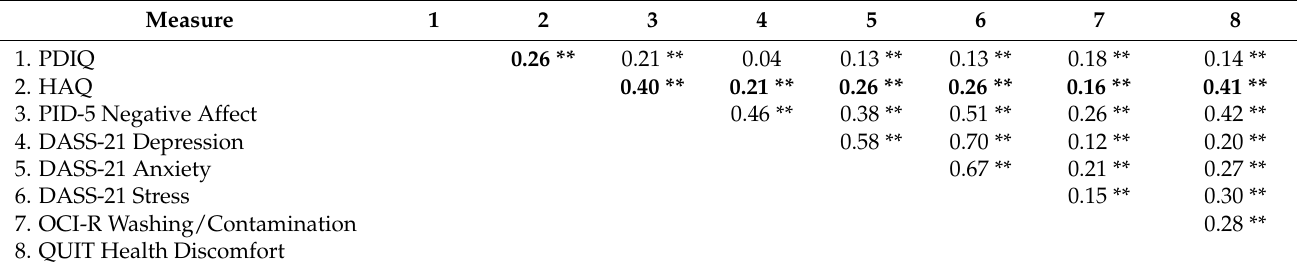
Table 1. Bivariate correlations (Pearson’s r s) among psychopathological variables ( N = 742).